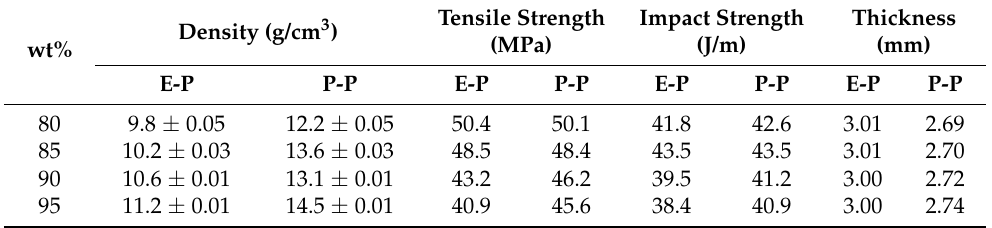
Table 1. Comparison of the properties of shielding films in terms of the tungsten content and polymer properties.